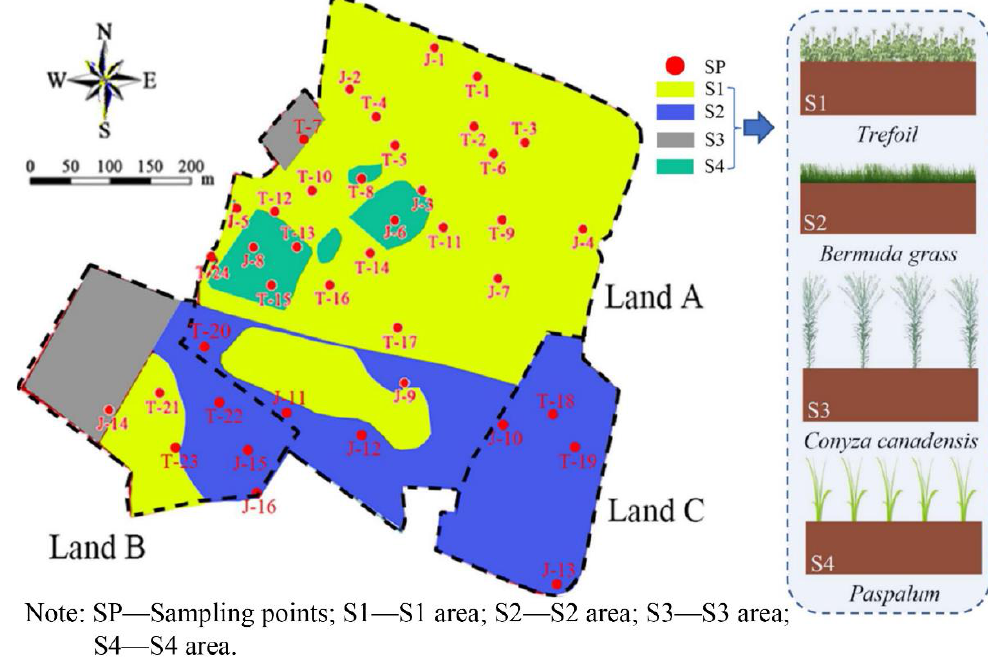
Figure 1. The soil sampling points at the test site and its vegetation coverage.